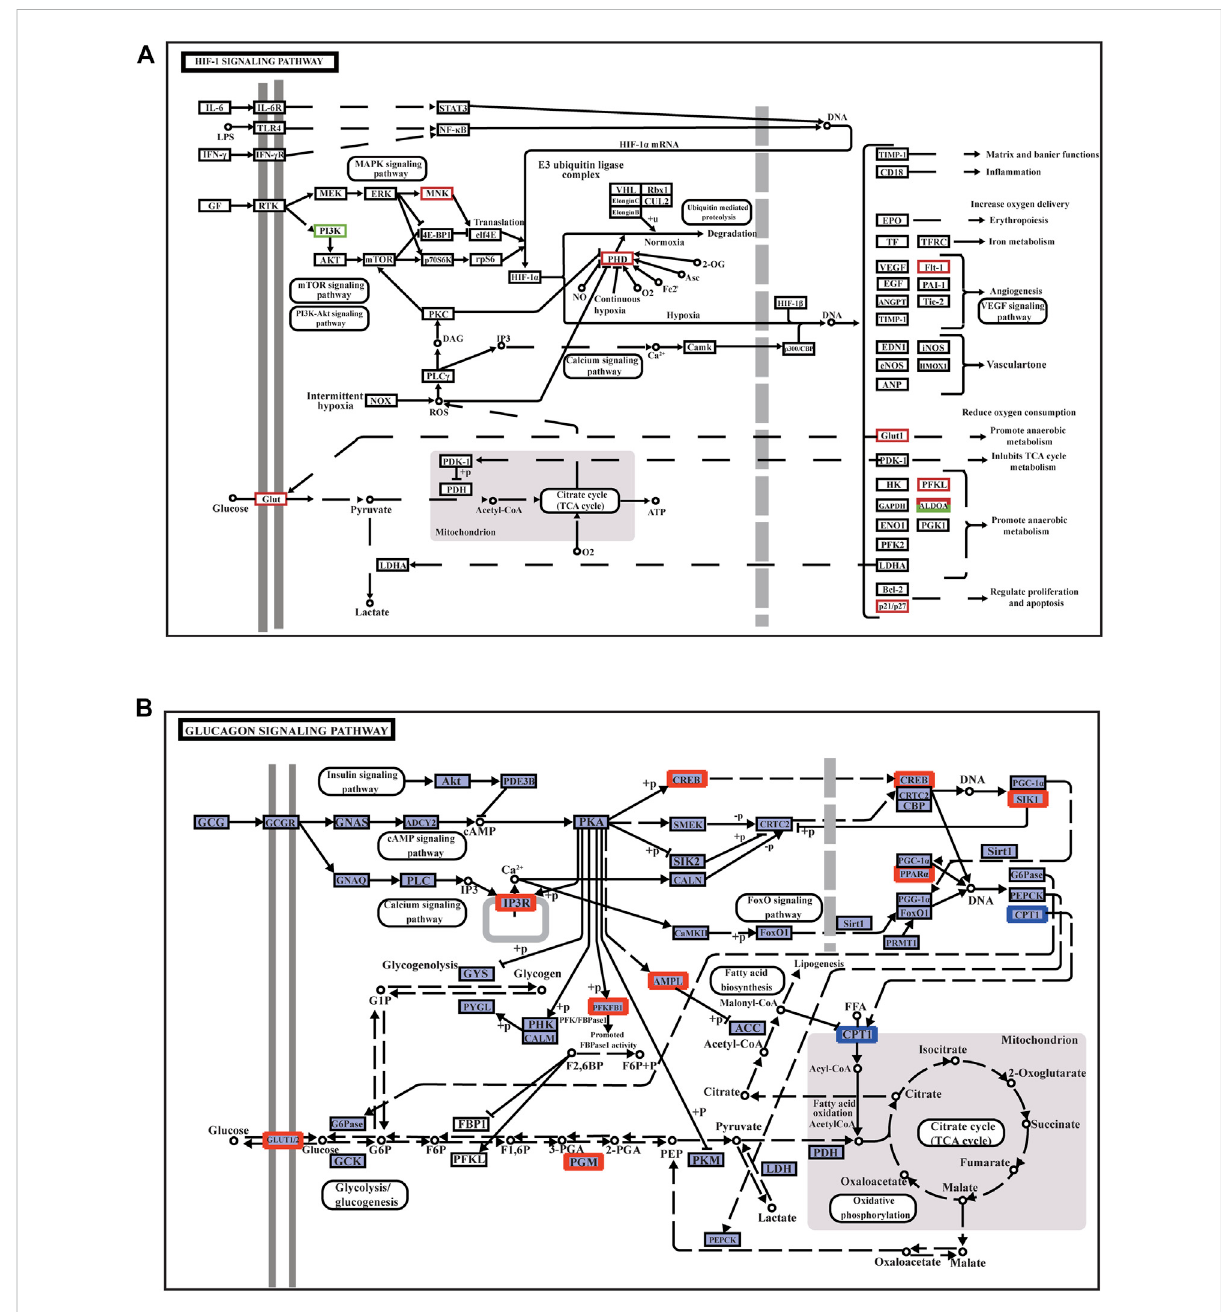
FIGURE 4 AnnotationdiagramofmusclesignalingpathwayanditsrelatedDEGs. (A) HIF-1signalingpathway. (B) Glucagonsignalingpathway.Theredbox indicates the upregulated genes in the pathways; the green box represents the downregulated genes in the